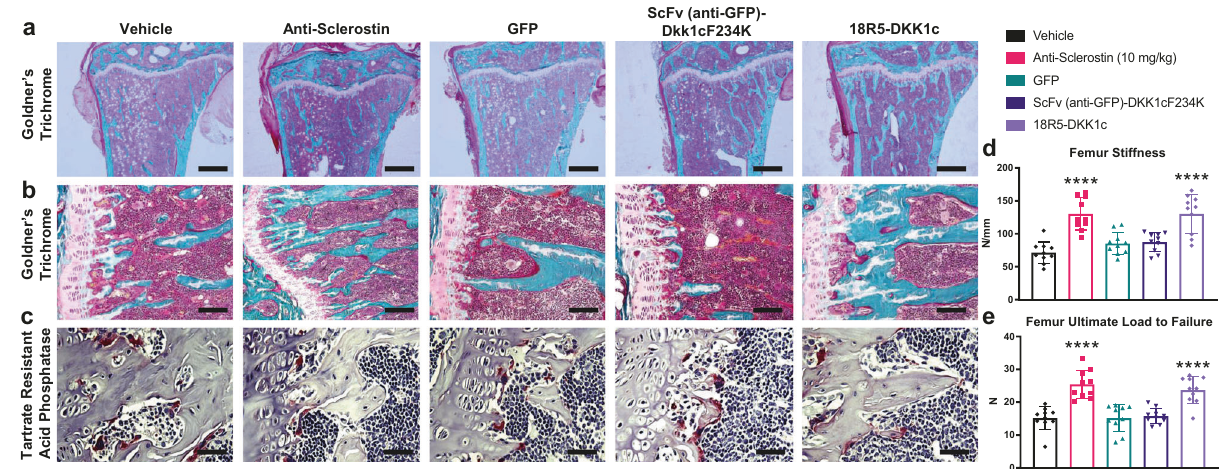
Fig. 3 Histology and mechanical testing of bone accrual induced by Wnt mimetics. a , b Tibias were isolated after 28 days, formalin fi xed, embedded in methyl methacrylate, sectioned longitudinally, and stained. Representative images of tibial sections from each treatment group at a 4× scale bar 1 mm and b 10× scale bar 200 µ m stained with Goldner ’ s trichrome (mineralized bone is colored blue) and c 40× scale bar 50 µ m stained for tartrate resistant acid phosphatase (TRAP). Femurs collected at study termination (day 28) were analyzed for bone strength at the mid-shaft femur by a standard 3-point bending test and quanti fi ed for d average femur stiffness and e average ultimate load to failure. a – c Representative images from n = 10 samples/group having similar results. d , e Bar graphs represent mean values± SD. Statistical signi fi cance was determined by one-way ANOVA, where **** p < 0.0001. The following letters de fi ne groups (a = Vehicle, b = Anti-Sclerostin, c = 18R5-DKK1c). d a vs. b, p ≤ 0.0001; a vs. c, p ≤ 0.0001. e a vs. b, p ≤ 0.0001; a vs. c, p ≤ 0.0001. n = 10 mice/group.